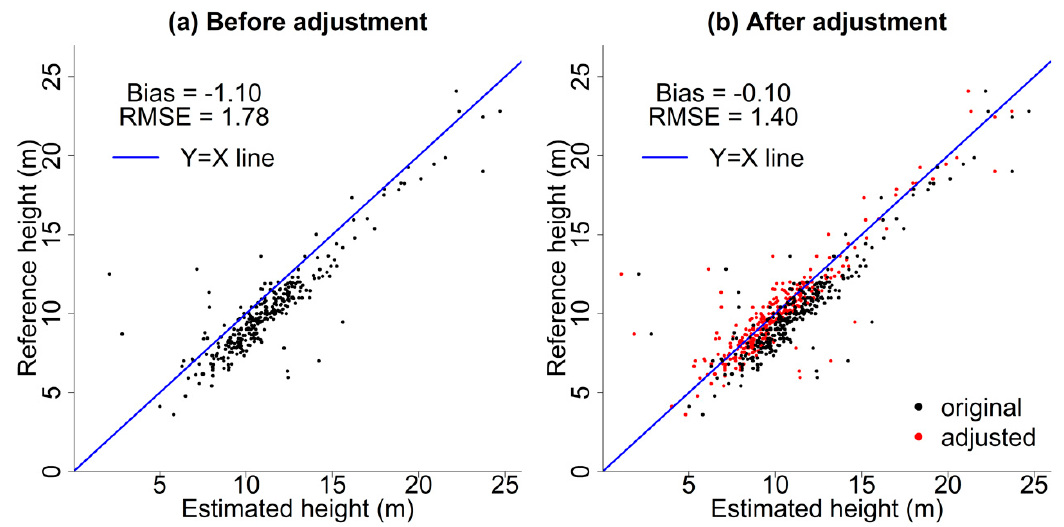
Figure 11. The comparisons between ( a ) original height estimation from the HPC-based MAXI surface and ( b ) adjusted height estimation with simple subtraction refine process using the radius = 3 m and intensity range = 0.05.